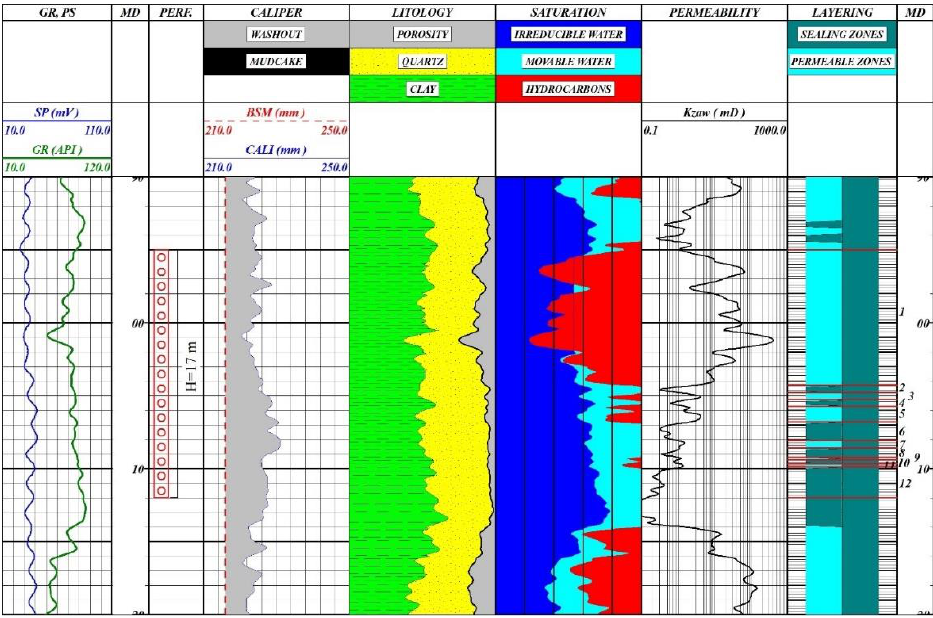
Figure 7. Results of the interpretation of the profile of permeability changes within the analysed perforation interval in the J-5K well. perforation interval in the J-5K well.